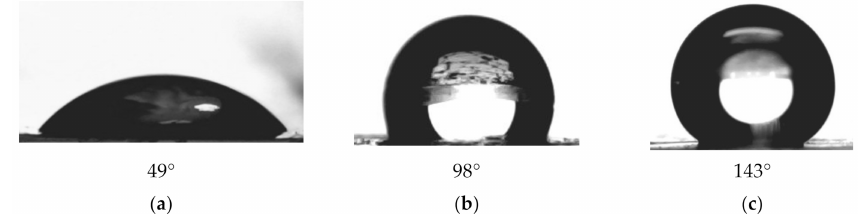
Figure 5. CA for original membrane (d ≈ 247 nm) ( a ), PET-Si membranes ( b ) and PET-Si-F membranes ( c